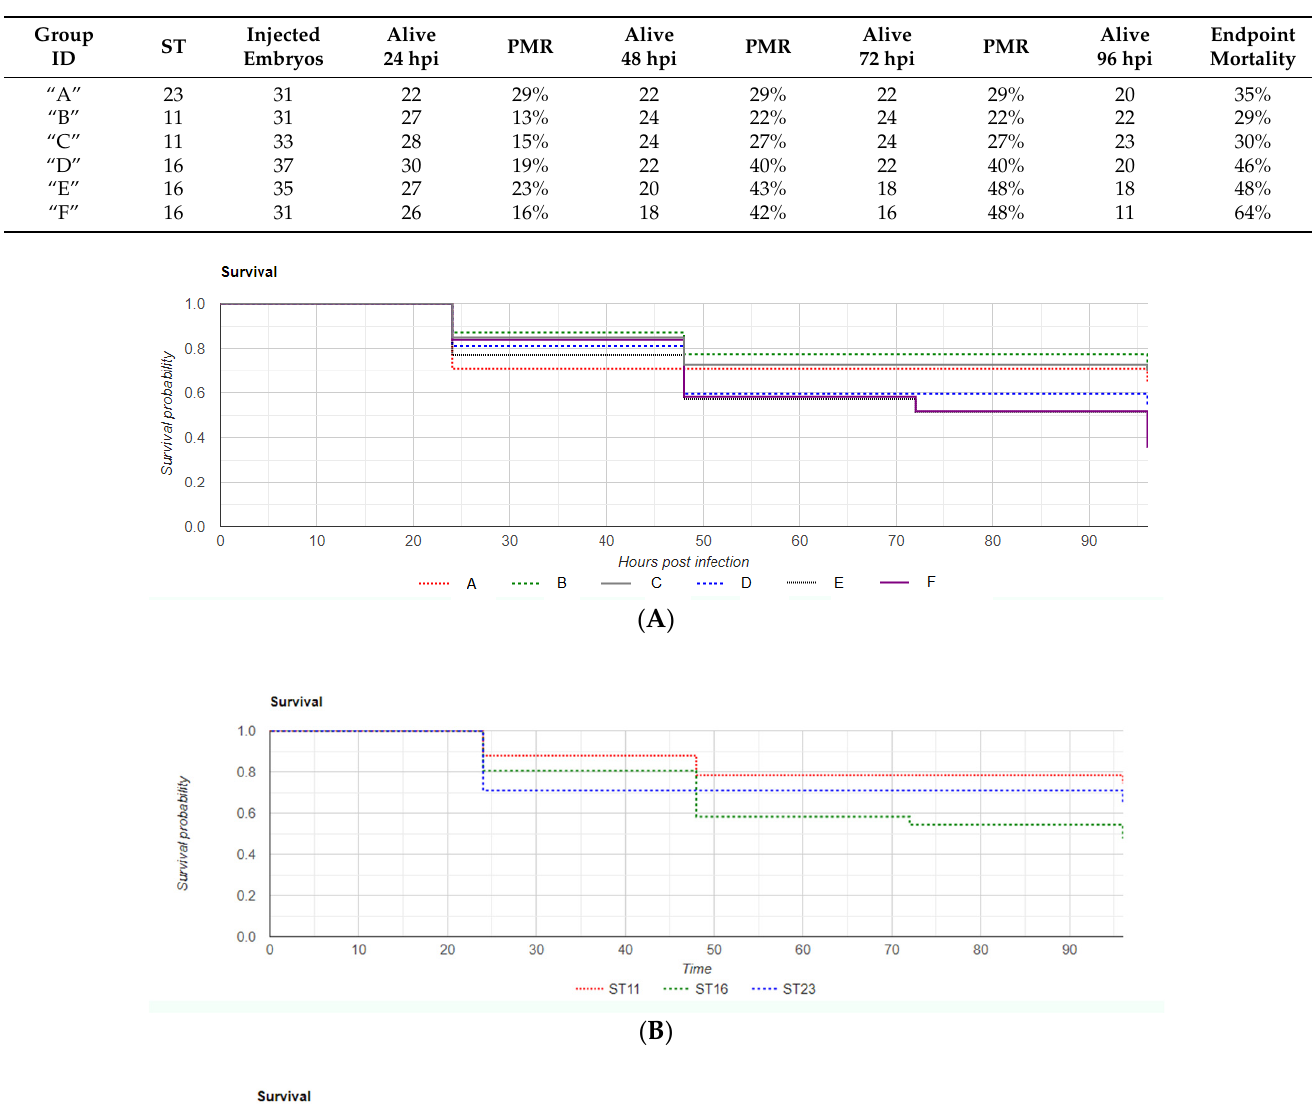
Table 2. Survival ( n ) and partial mortality rates (PMR) of each group at 24-, 48-, 72-, and 96-h post-infection (hpi). Group IDs correspond to the strains used to infect embryos in each group.